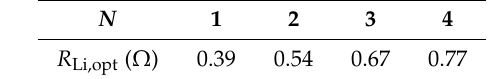
Figure 13. Comparison of system efficiency after efficiency optimization. 5. Conclusions